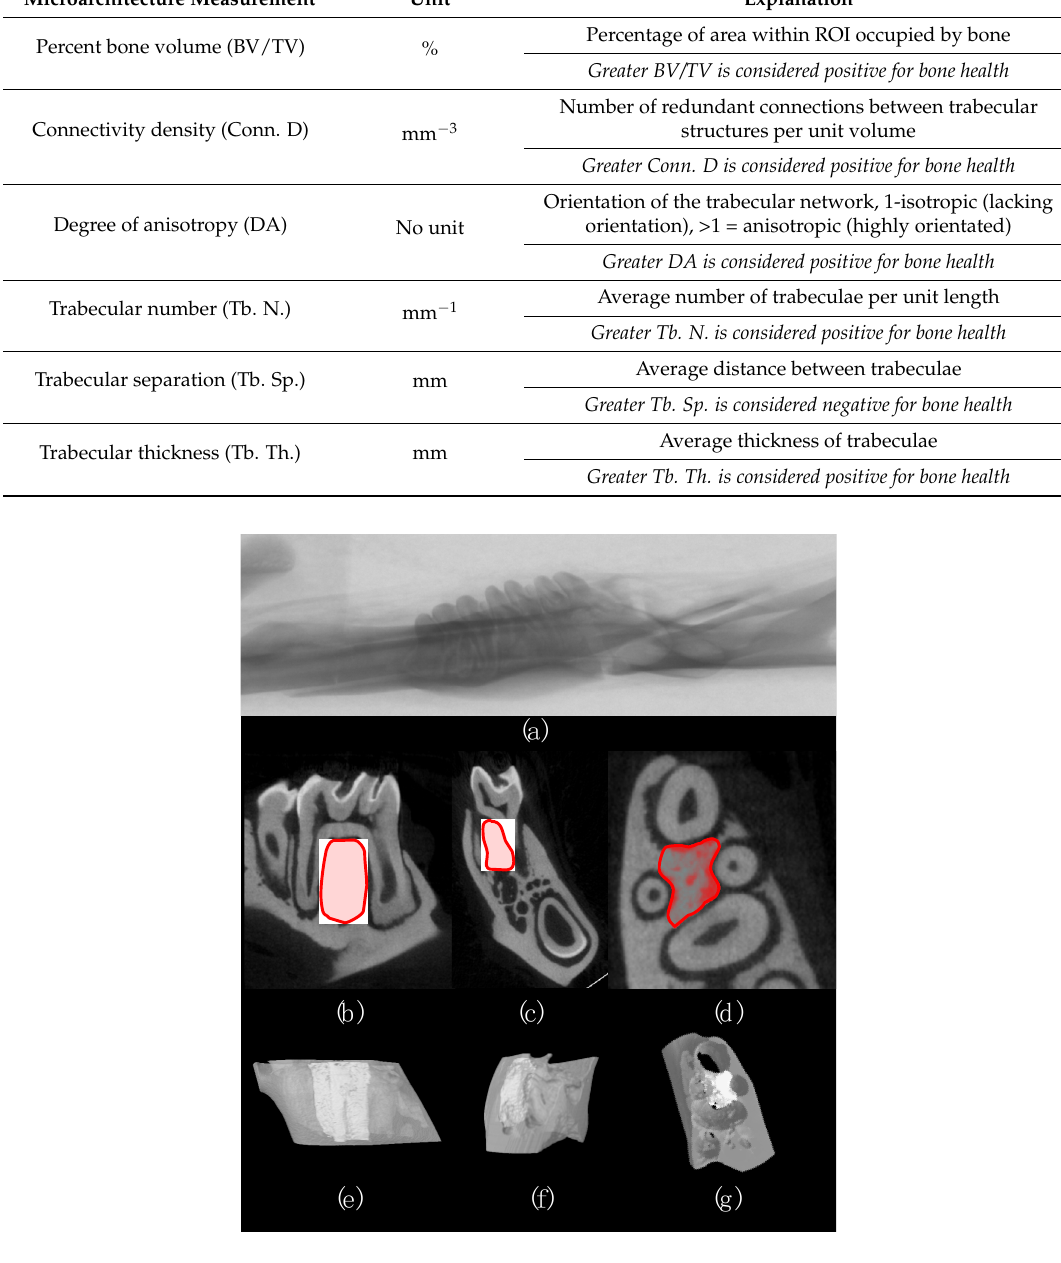
Figure 1. Representative image of a rat ( a ) hemi mandible; ( b – d ) sagittal, coronal, and transverse cross ‐ section of the first molar with the region of interest (ROI) in the inter ‐ radicular septum defined in red; ( e – g ) 3 ‐ dimensional representation of the volume (grey) surrounding the ROI (white).